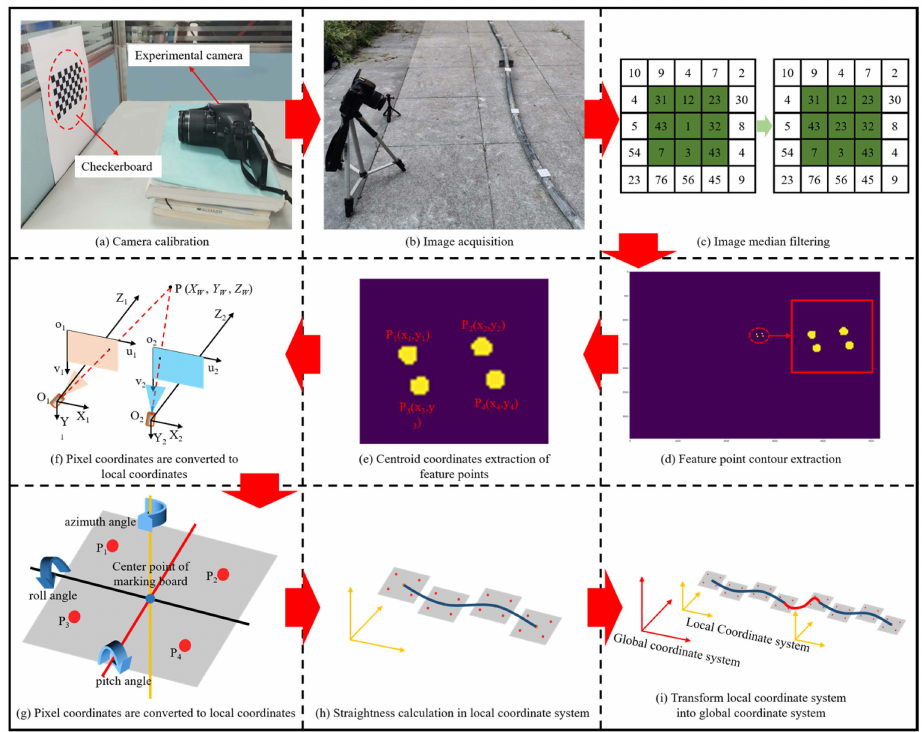
Figure 5. Process of measuring straightness of scraper conveyor based on binocular